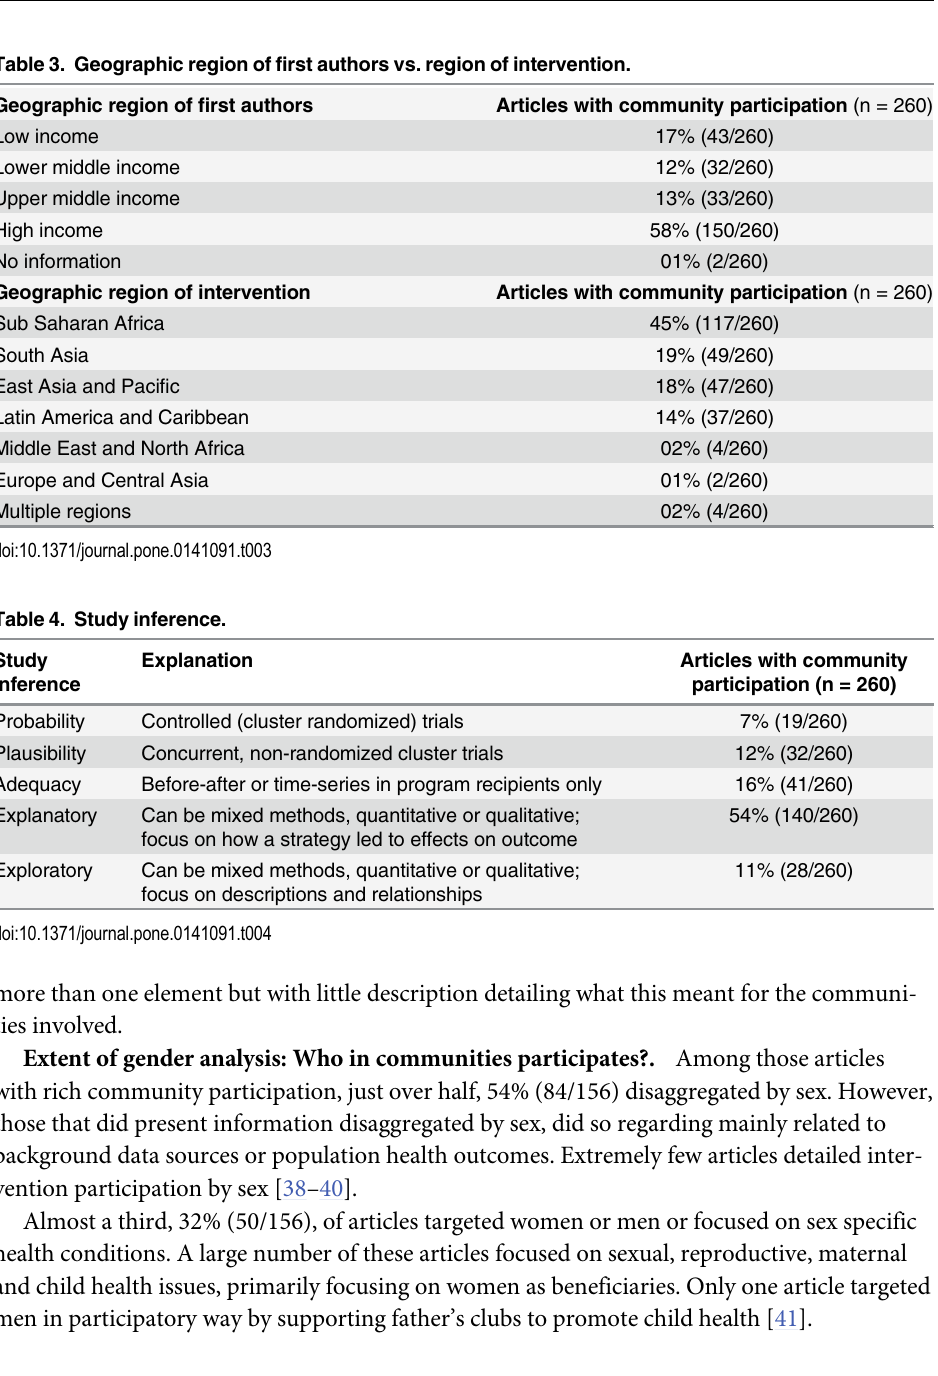
Table 5. Nature of community participation. Nature of community participation